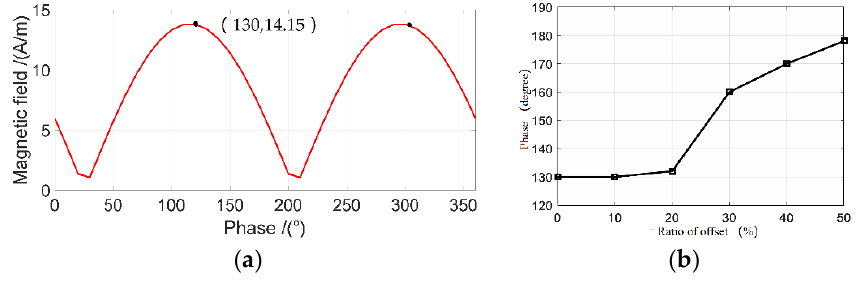
Figure 14. Phase of the primary current: ( a ) phase of the primary current at test point A3; ( b ) relationship between the offset and the phase of the maximum magnetic field.